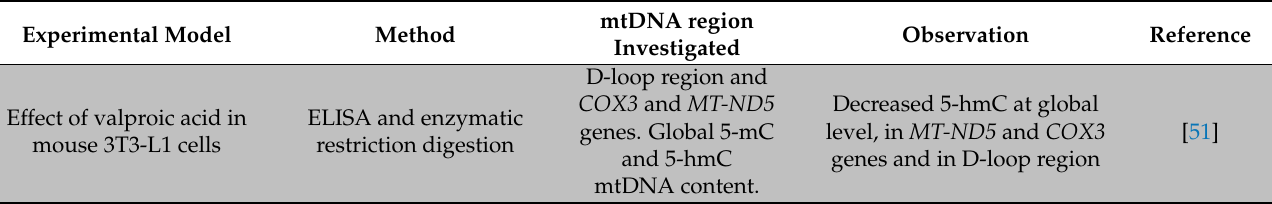
Table 6. Epigenetic effects of exogenous and endogenous molecules and of genetic variants on mtDNA methylation and